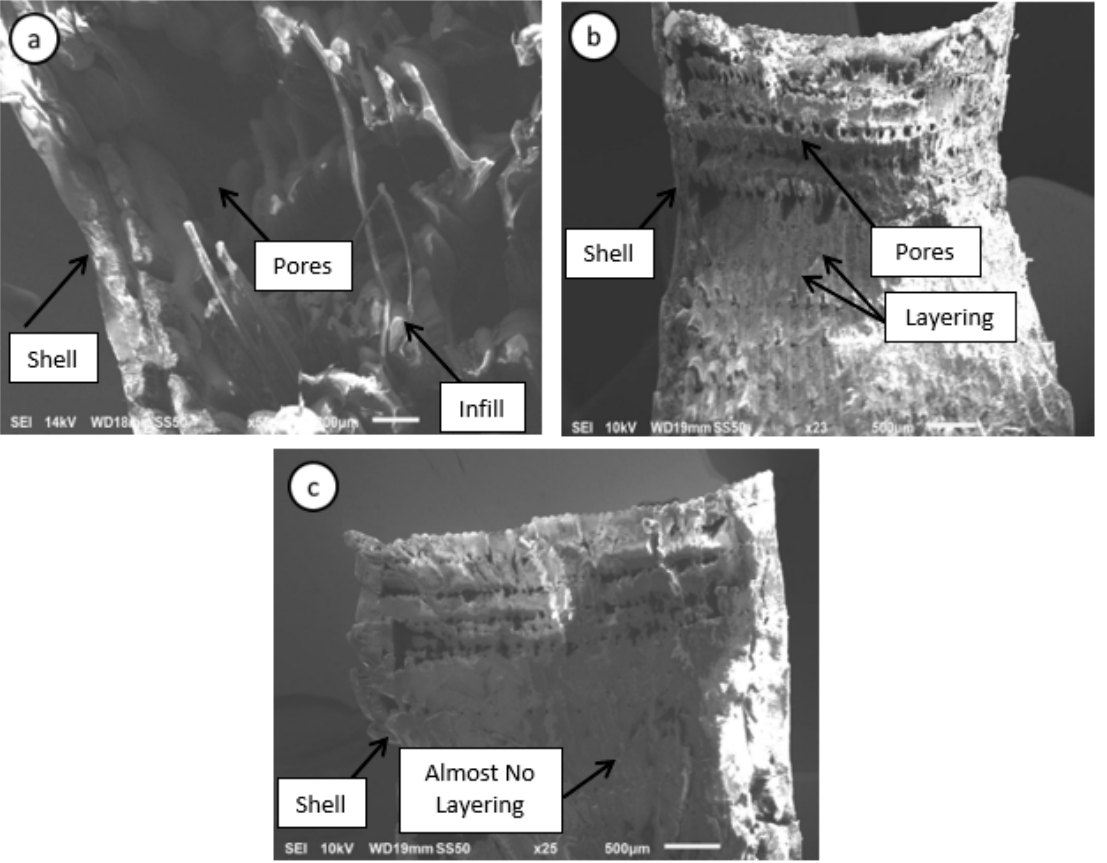
Figure 19. Scanning electron microscope (SEM) images for the fractured surfaces. ( a ) White ( b ) Gray ( c )